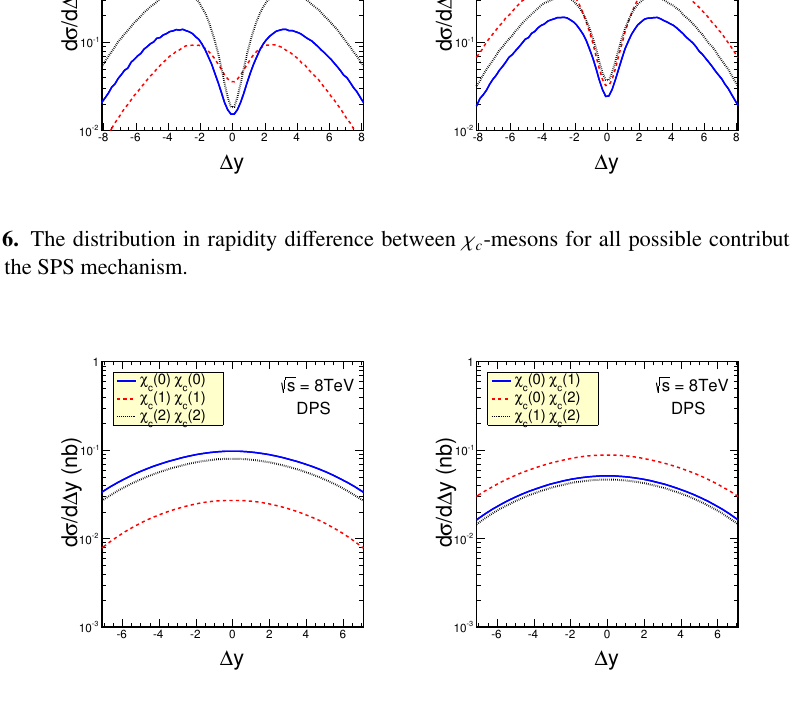
Figure 7. The distribution in rapidity di ff erence between χ c -mesons for all possible contributions of χ c ’s for the DPS